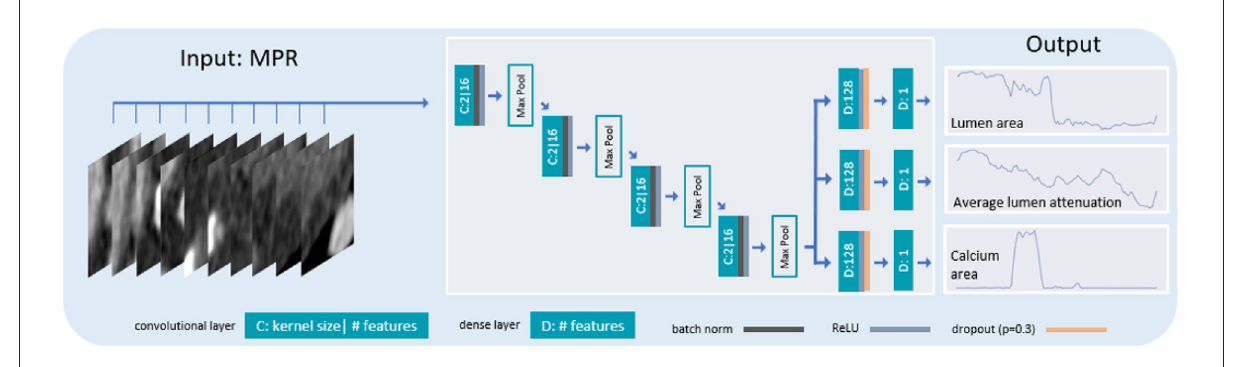
FIGURE4 Architecture of the network for extracting artery characteristics. Stacks of 3 cross-sectional artery slices are fed to a 2D CNN with 4 pooling layers interleaved with convolutions. The network is trained to predict the lumen area, its average attenuation and the calcium area for the central slice of the 3 input slices.